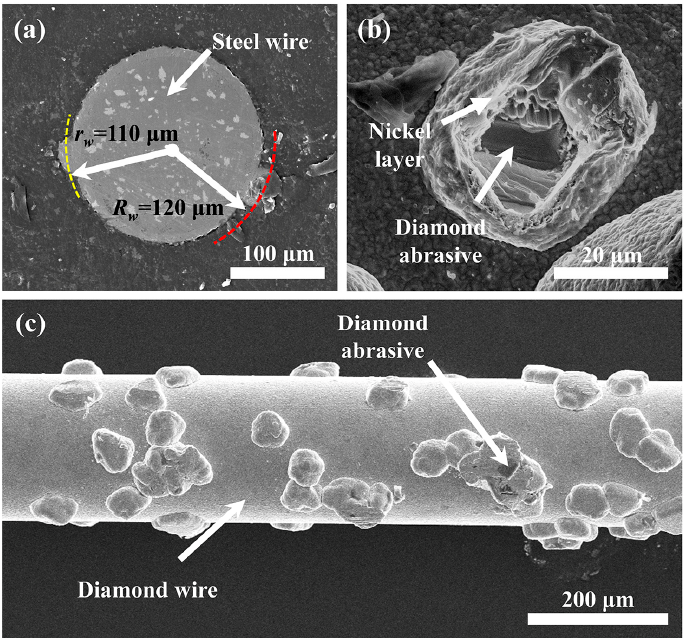
Figure 3. The kerf width sawed at P = 0.21 MPa and v s = 1.8 m/s. However, the maximum radius ( R w ) of the diamond wire applied in this experiment was around 120 µ m, and the effective cutting radius ( r w ) was approximately 110 µ m, as shown in Figure 4. Therefore, the actual kerf width is at least 20 µ m larger than the maximum outer diameter of the diamond wire, which indicates that the diamond wire not only moved along the cutting direction but also along the lateral direction during the sawing process.